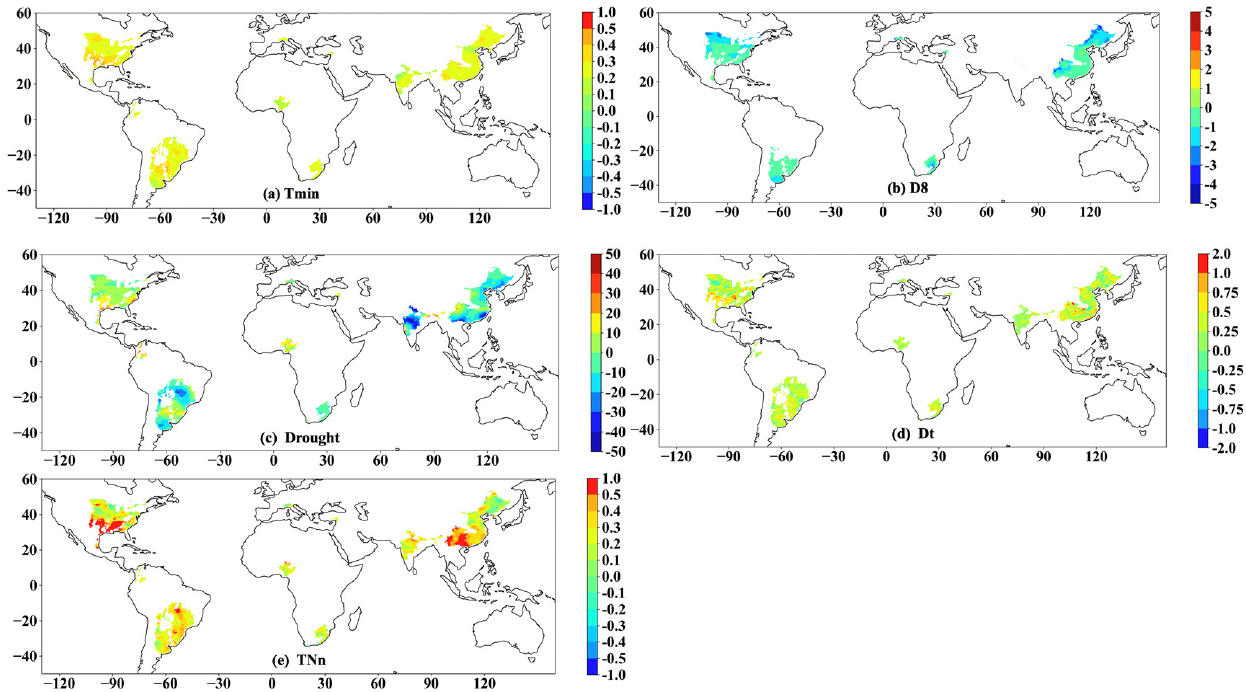
Figure 9. The trends of extreme climate indicators during soybean growing season from 2040 to 2099 (per 10a). ( a ) Tmin ( ◦ C/10a) stands for mean value of daily minimum temperature. ( b ) D8 (days/10a) stands for days of daily minimum temperature < 8 ◦ C. ( c ) Drought (mm/10a) stands for the difference between actual evapotranspiration and cumulative precipitation. ( d ) Dt ( ◦ C/10a) stands for mean value of daily mean temperature during maximum continuous drought days (daily precipitation < 2 mm). ( e ) TNn ( ◦ C/10a) stands for minimum value of daily minimum